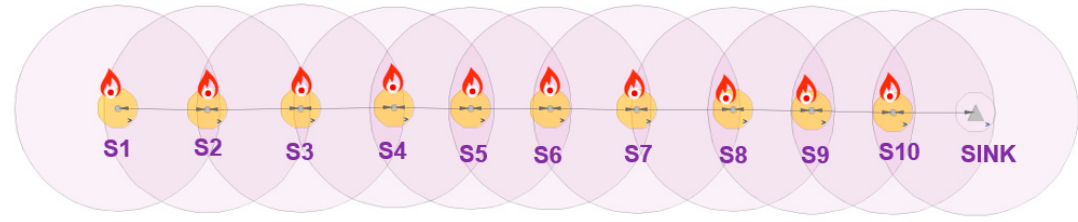
Figure 16. Simulation of a linear WSN consisting of ten sensor nodes and one sink node.